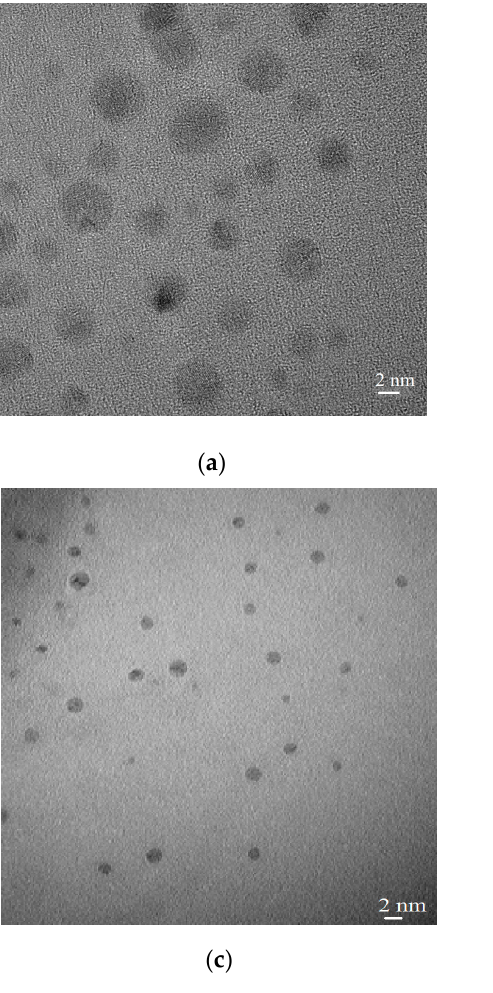
Figure 3. HRTEM images of the nanoparticles: ( a ) Ag with a particle size of 5 nm, ( b ) Ag with a particle size of 10 nm, ( c ) Au with a particle size of 5 nm, and ( d ) Au with a particle size of 10 nm.